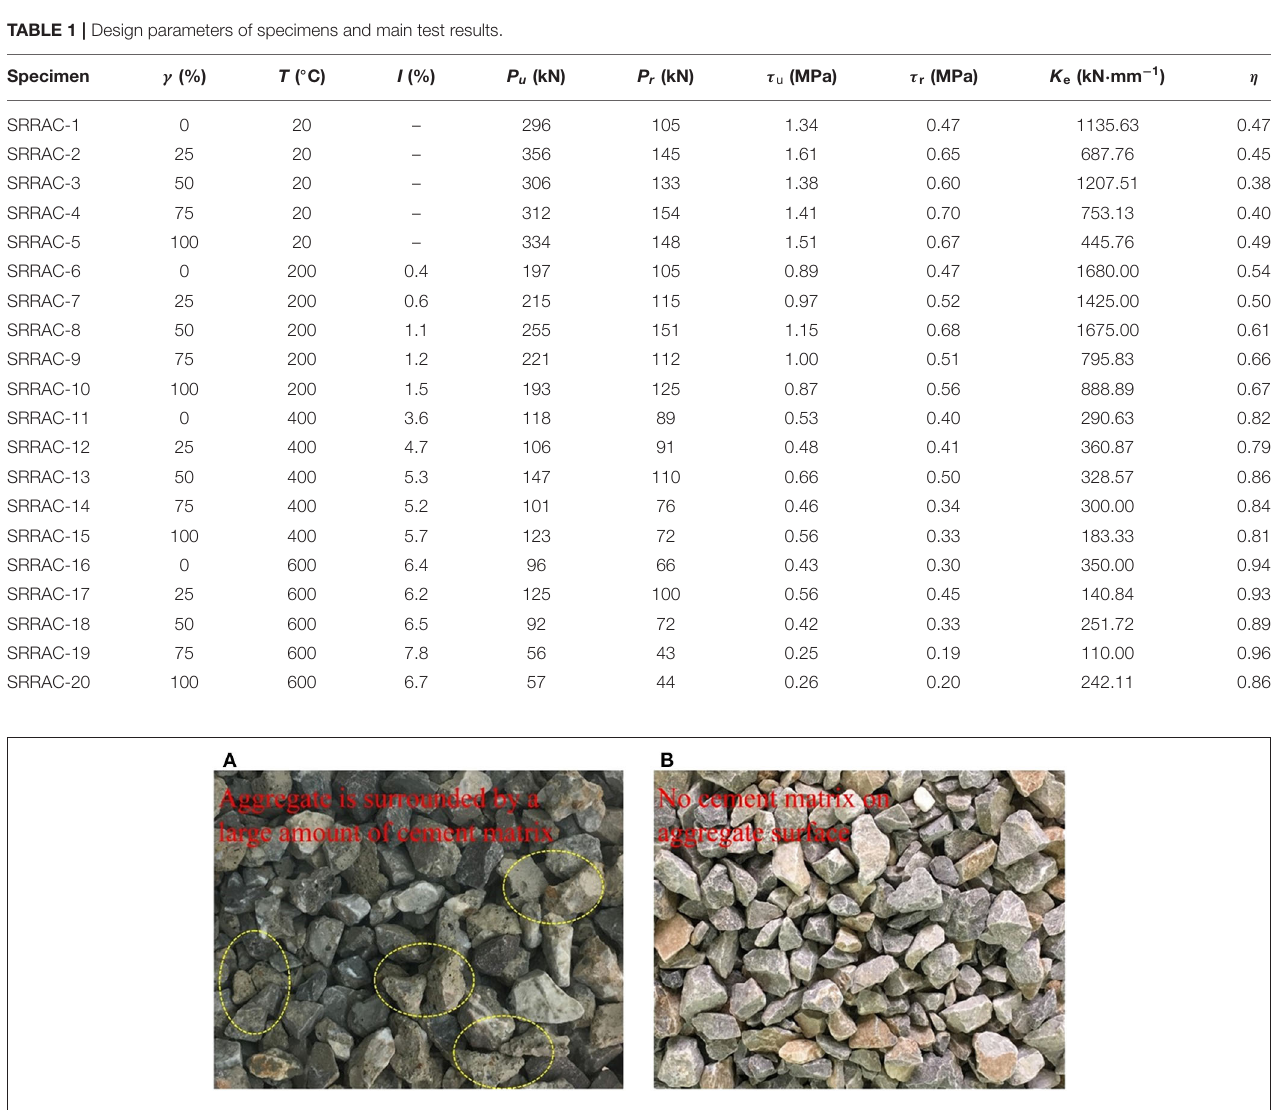
FIGURE 2 | Recycled and natural coarse aggregates: (A) recycled gravel; (B) natural